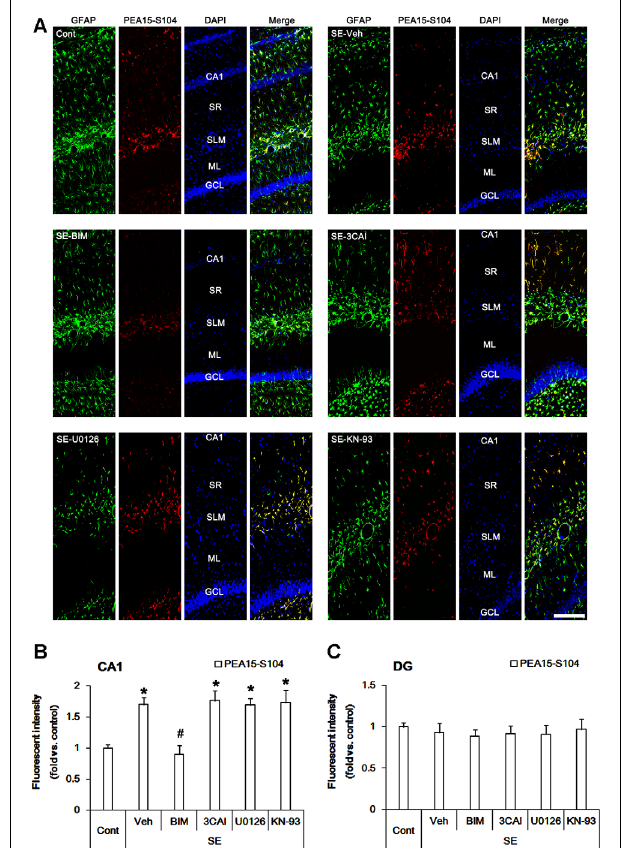
FIGURE 2 | Alterations in PEA15-S104 phosphorylation in the hippocampus following SE. SE enhances PEA15-S104 phosphorylation in CA1 astrocytes, which is reversed by BIM, but not 3CAI, U0126 and KN-93. SE does not influence PEA15-S104 phosphorylation in dentate astrocytes, which is unaffected by BIM, 3CAI, U0126 and KN-93. (A) Representative immunofluorescent images for GFAP and PEA15-S104 phosphorylation following SE. Bar = 100 µ m. Abbreviations: CA1, CA1 pyramidal cell layer; SR, stratum radiatum; SLM, stratum lacunosum-moleculare; ML,